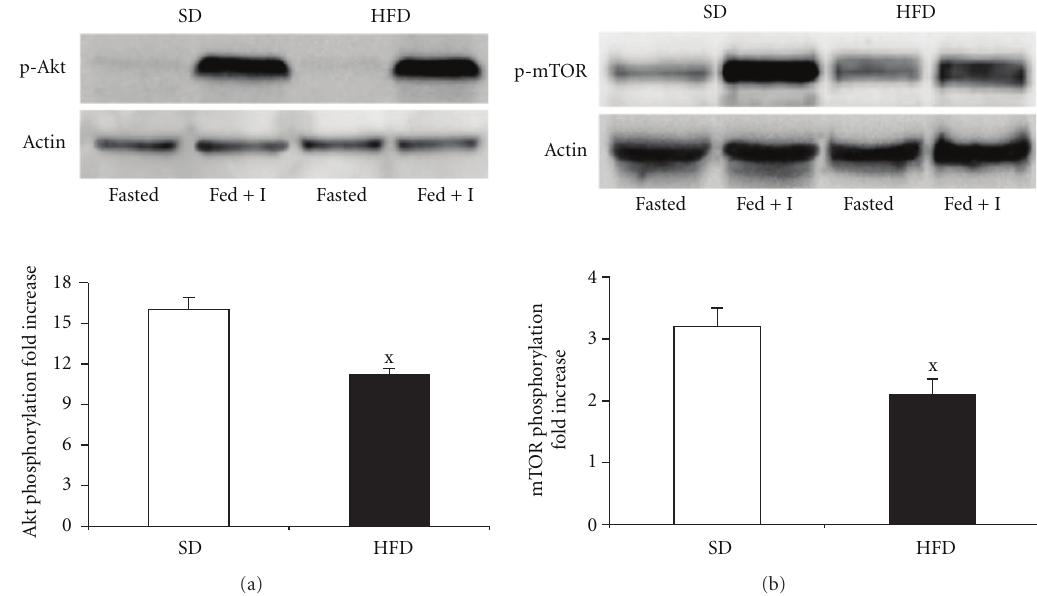
Figure 6: Alterations of insulin signalling cascade associated with hepatic fat accumulation. All results are expressed as a fold increase in the insulin-stimulated state relative to the basal state. Representative Western blots are shown above each graph. (a) Fold increase in Akt (Ser473) phosphorylation, (b) fold increase in mTOR (Ser2448) phosphorylation. The basal level of protein phosphorylation was determined in the homogenate prepared from the liver of 24 hours fasted animals. The e ff ect of insulin was determined in identically processed samples from animals which had free access to food and 40 min prior to decapitation were administered insulin 6U/kg. The total protein (Akt or mTOR) expression was determined after striping the membrane and reblotting with anti-Akt or anti-mTOR antibody. Values represent means ± S.E.M. of 7 animals. x P < 0 . 05.